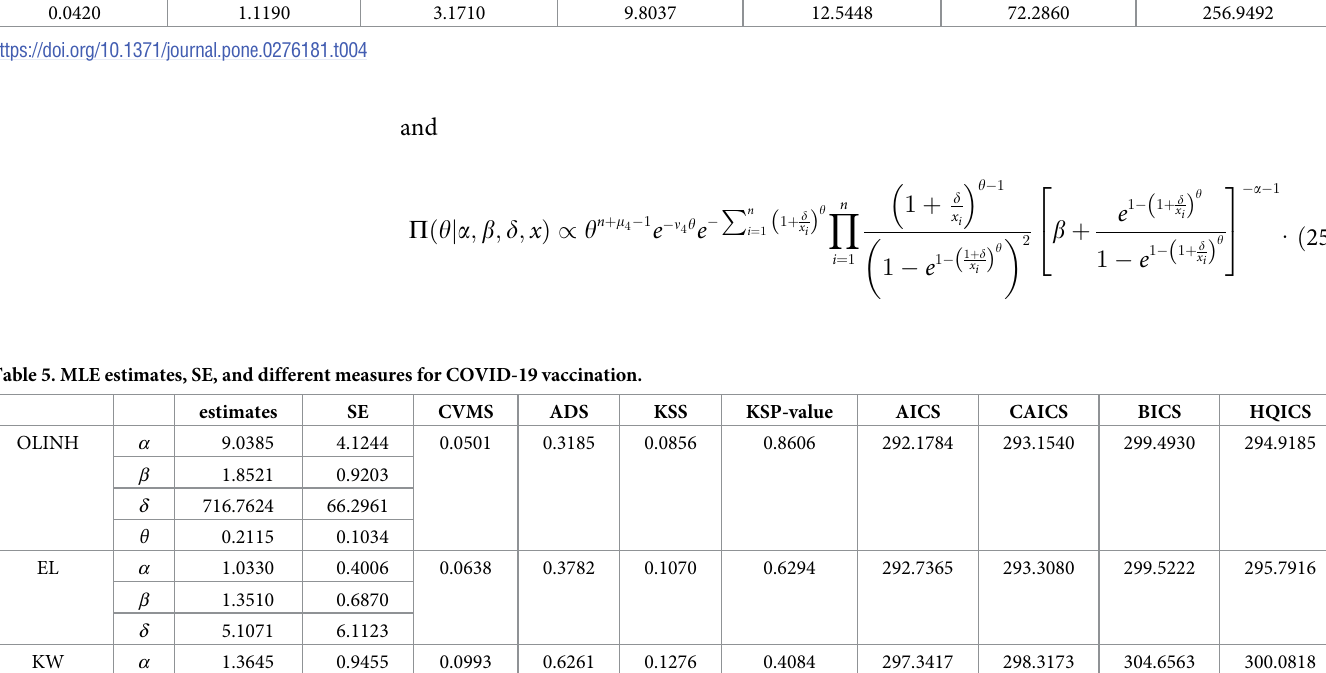
Table 4. Minimum, first and third quarterly, median, mean and variance for COVID-19 vaccination. Min. 1st Qu. Median Mean 3rd Qu. Max. var